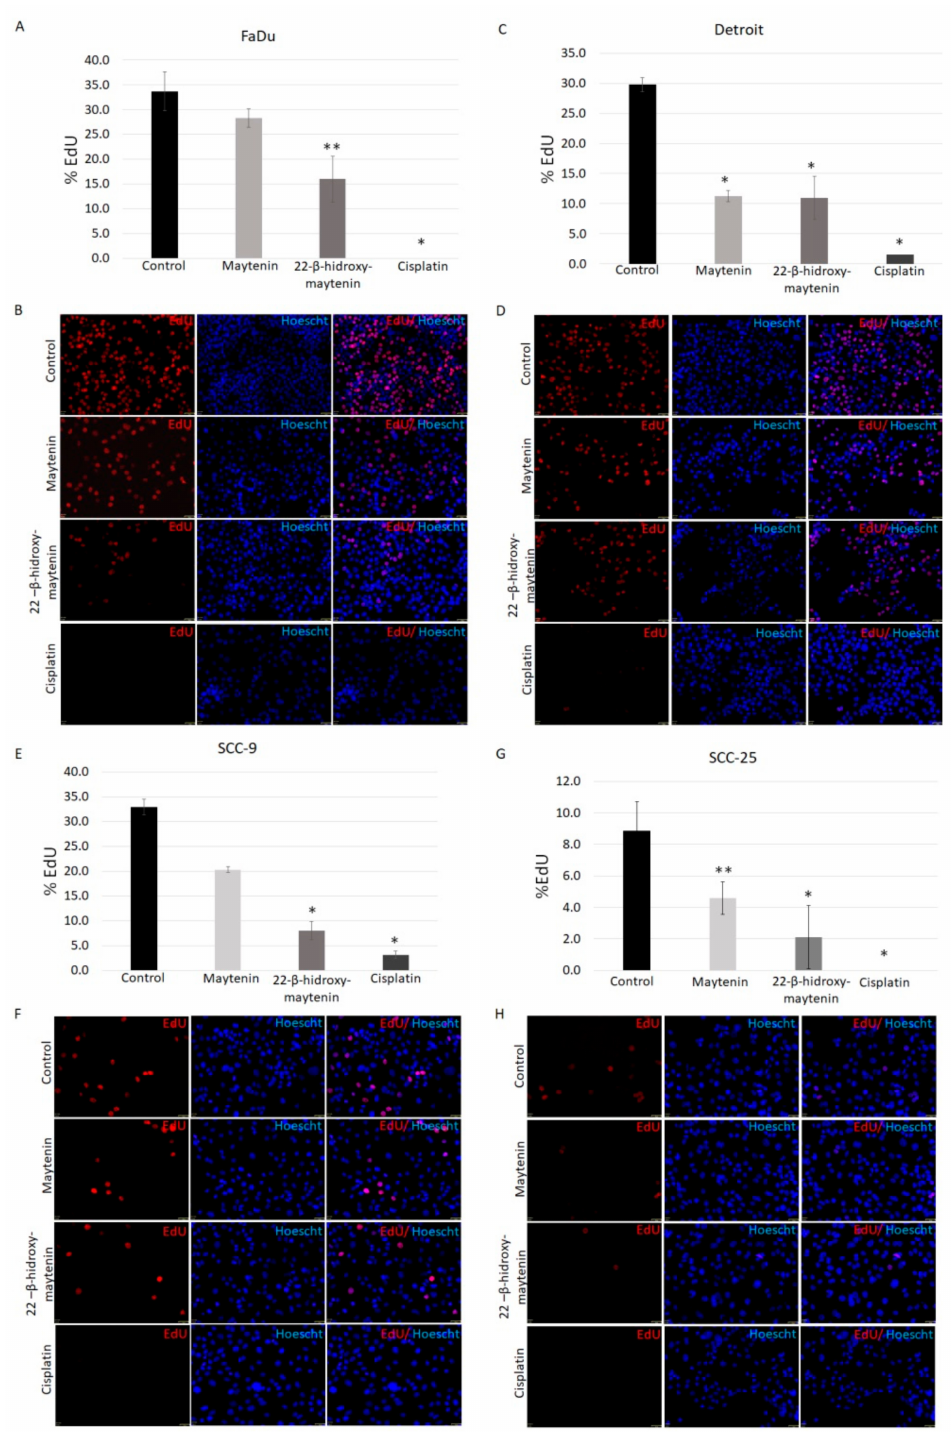
Figure 4. Anti-proliferative e ff ects of maytenin, 22- β -hydroxymaytenin and cisplatin measured by EdU incorporation into DNA. Column graphs ( A , C , E , G ) show the percentage of cells staining for EdU (red) compared to Hoechst 33,342 (blue) stained nuclei ( ± SD). There were two replicates in each experiment and all cells were counted for each treatment. Images ( B , D , F , H ) were taken on a fluorescence microscope (magnification × 20) and depict EdU incorporation (red) and Hoechst 33,342 nuclei staining. EdU incorporation occurs during DNA synthesis, EdU positive cells indicate DNA replication and consequent cell cycle progression. * p < 0.01. ** p <